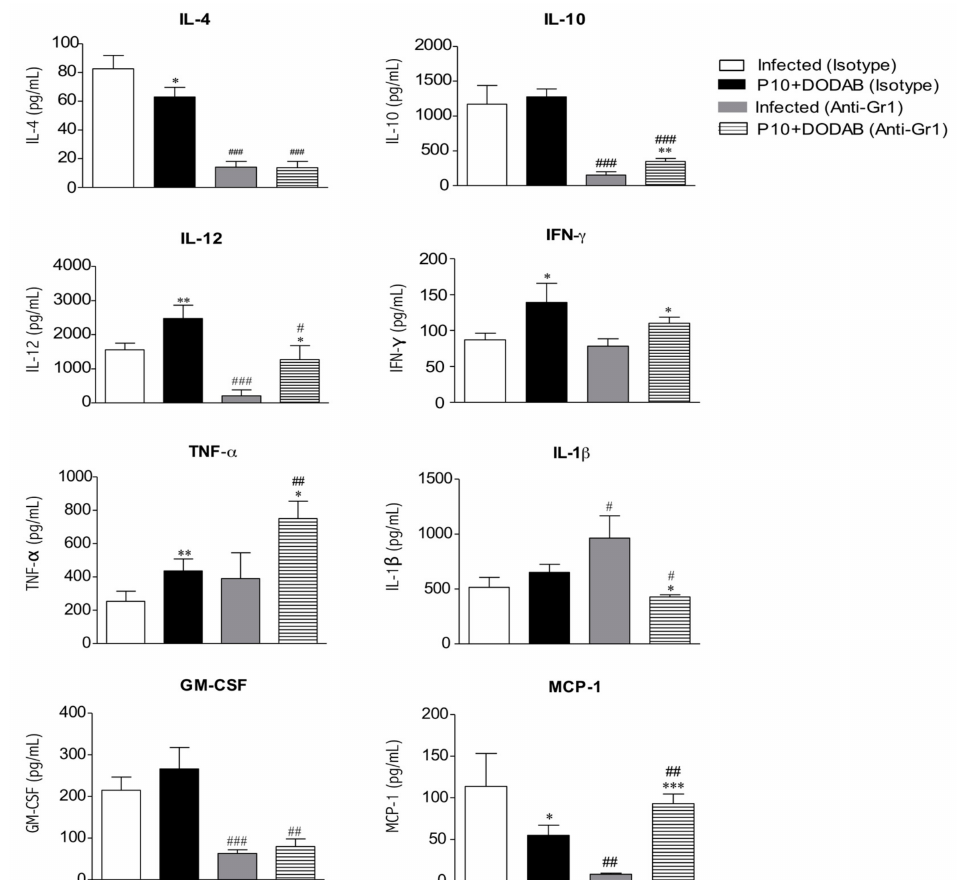
Figure 3. Neutrophil depletion before therapeutic vaccine impacts cytokine production. Infected mice were untreated and given neutrophil-depleting antibody Gr1 [Infected (anti-Gr1)] or an IgG2b isotype control [Infected (Isotype)] at days 14, 21, and 28 post infection. Additional mice were infected and given neutrophil-depleting antibody Gr1 or an IgG2b isotype control at days 14, 21, and 28 post infection, and were vaccinated at days 15, 22, and 29 post infection with P10+DODAB (P10+DODAB (anti-Gr1) and P10+DODAB (Isotype), respectively). Mice were euthanized 36 days post infection and the cytokine levels in the lungs were quantified. Data are representative of three independent experiments (mean ± SD). Statistical comparison by One-way ANOVA related to depletion (Infected (Isotype) vs. P10+DODAB (Isotype) or infected (anti-Gr1) vs. P10+DODAB (anti-Gr1)): * p ≤